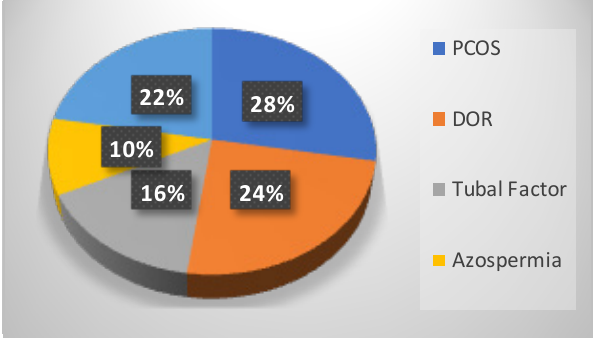
FIGURE 1 - Average age of female subjects was 30